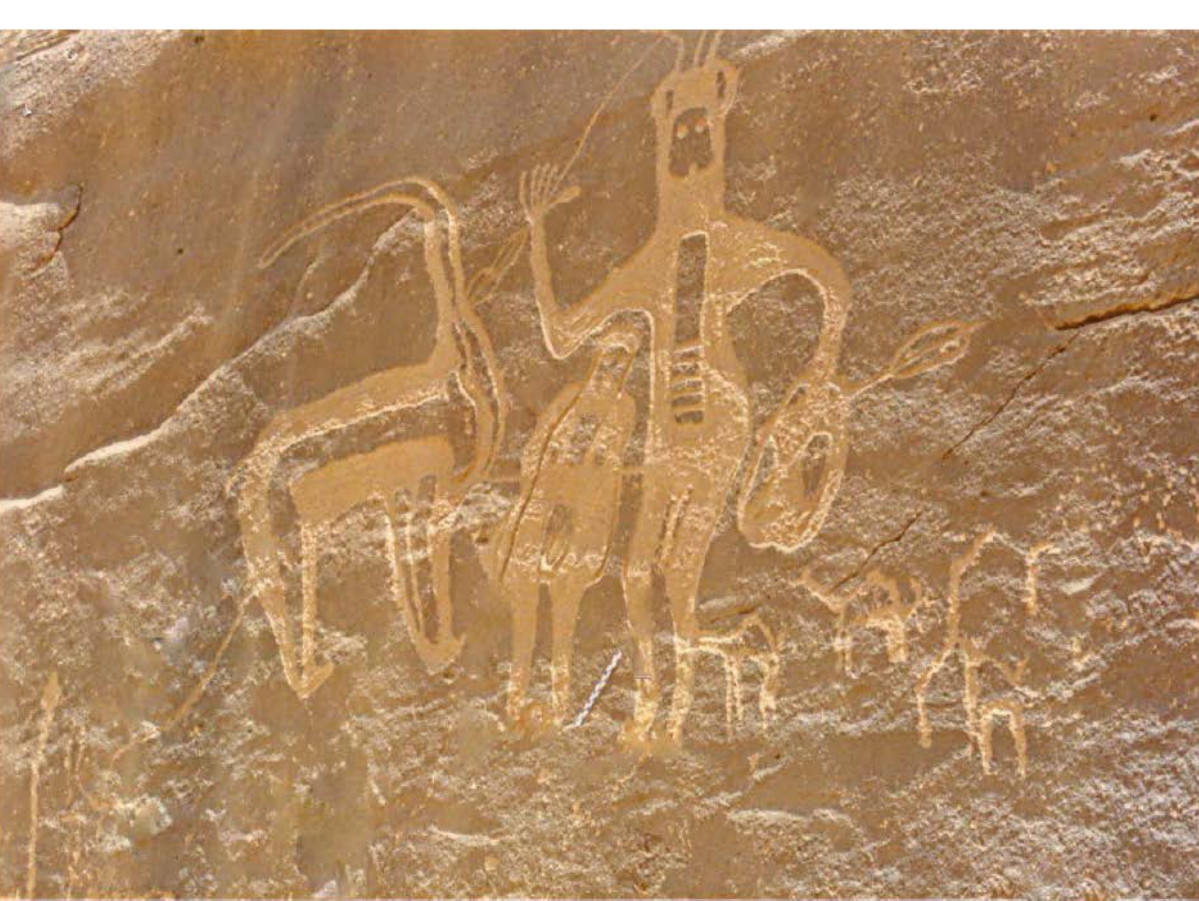
Figure 19. This unique and meaningful composition of human and animal figures is located north of Himma, Najran, Southern Arabia. It is carved on a hardly accessible, steep and vertical surface of a 200-m-high hill. The figures are facing east and are visible from a long distance. There is absolutely no place to stand on the steep hill surface to carve the figures. It was even difficult to photograph the panel. Perhaps the artist might have descended from the top of the hill, hanging on a rope to carve the figures. The man is tall and muscular while the woman is short and stout. Man, woman, and the “ibex” are placed closely to show complete synchronization and unity. The panel gives the impression as if the artist wanted to represent love, sex, and man’s power and superiority over the woman. He seems to be holding a shield and a lance in the left arm and a spear in the right arm, touching the horns of the “ibex”. The female is depicted under the armpit of the man, slightly bending as if seeking protection under the arm of the man. The artist has emphasized the sexual traits. The camel figures on the same rock are later